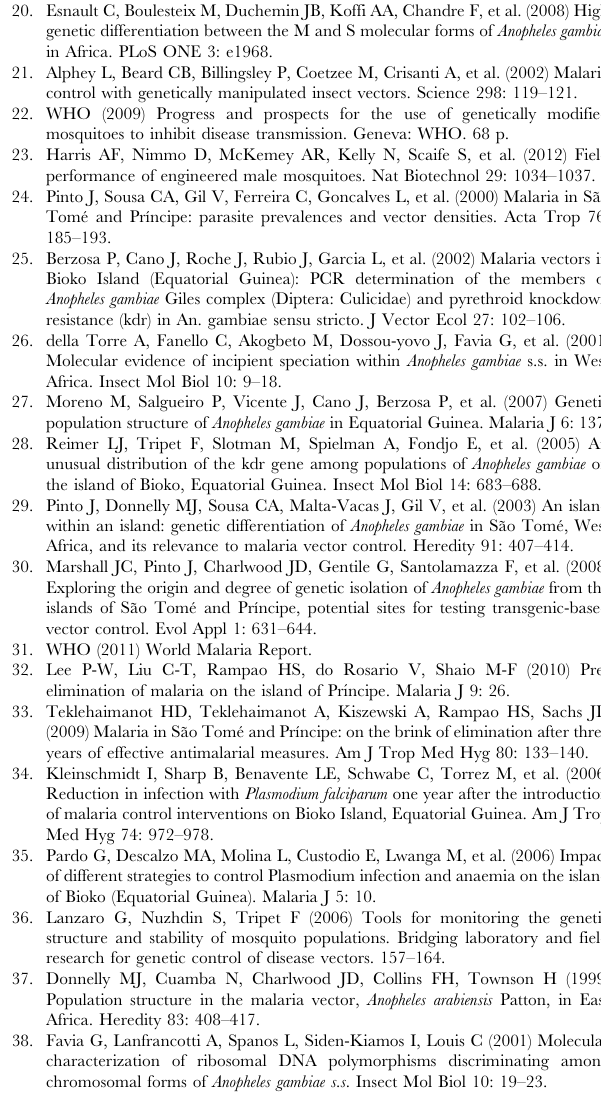
Table S1 Distribution of Herves sites detected over the six sampled